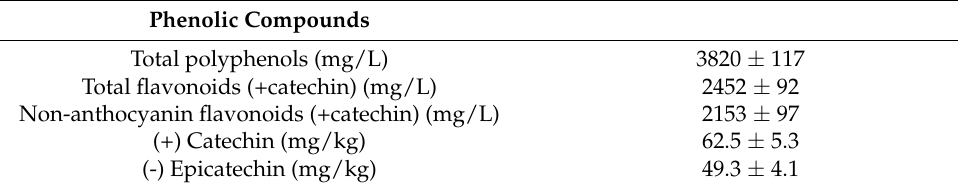
Table 1. Concentrations of the main phenolic compounds in red wine “ Vitis Vitae